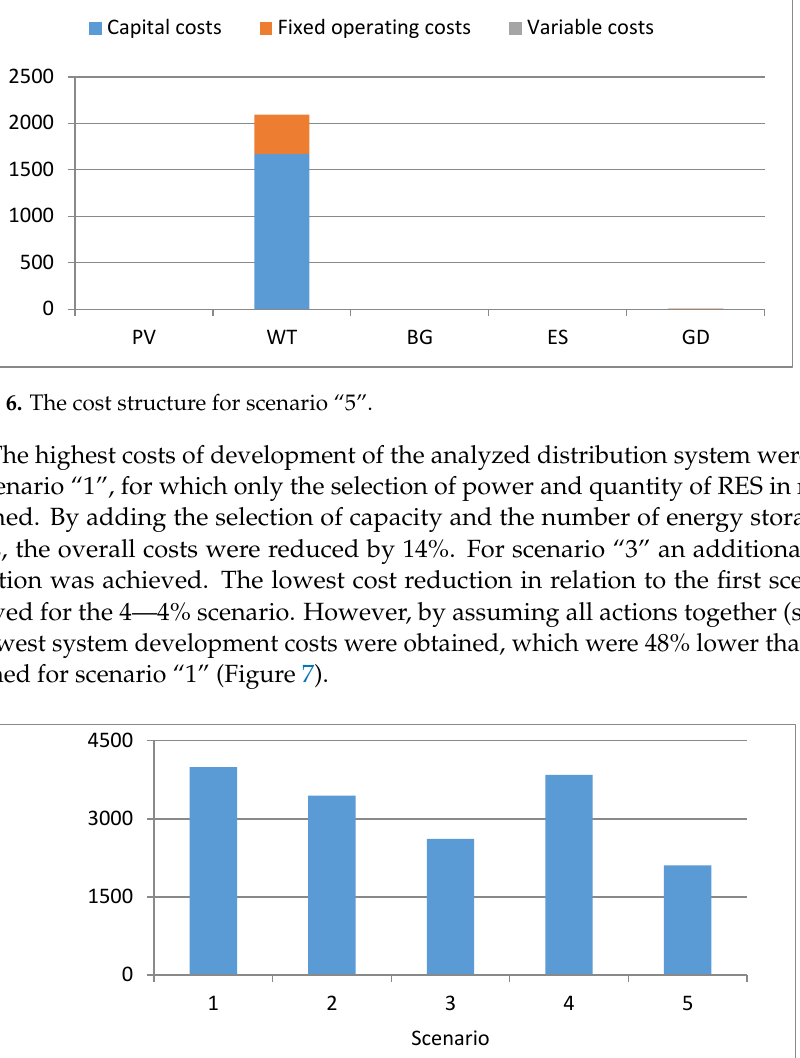
Figure 5. The cost structure for scenario “4”.